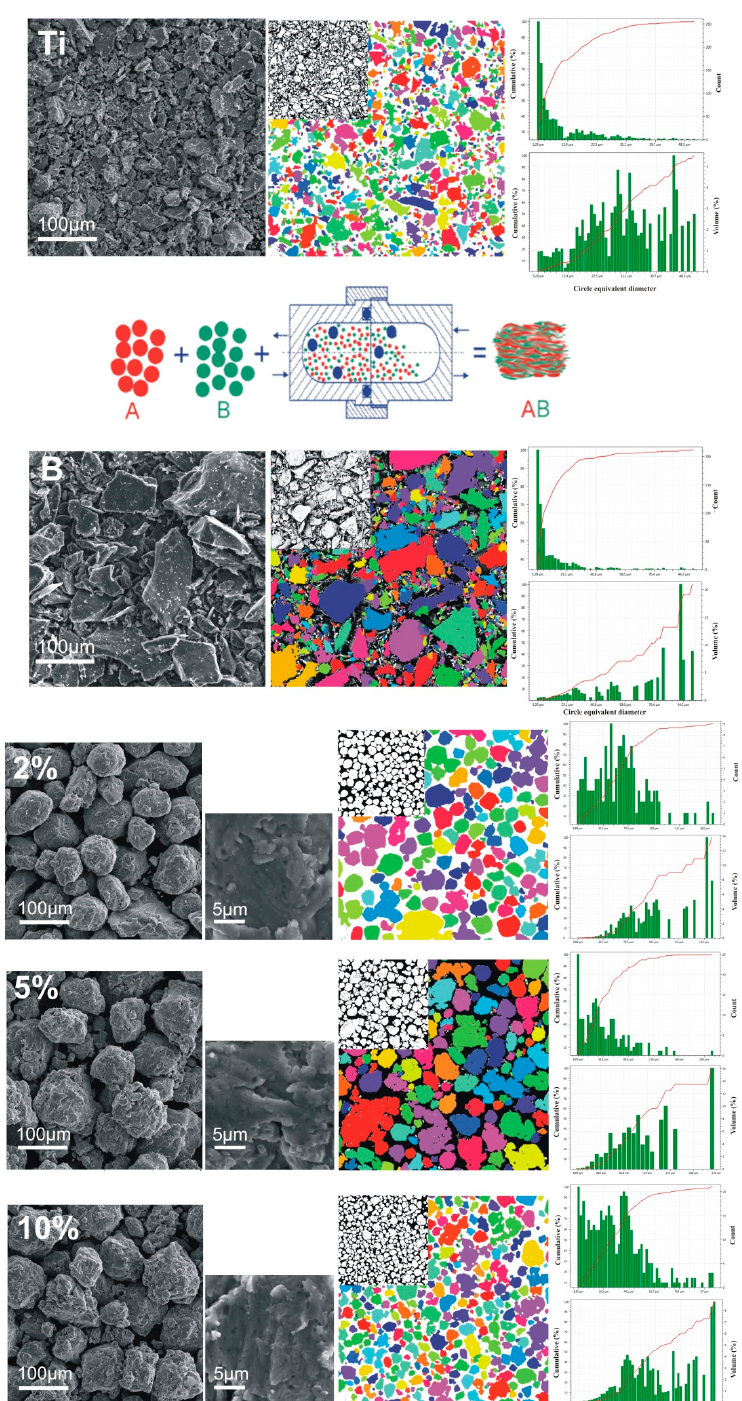
Figure 3. SEM microphotographs showing the powder blends processing stadium from the starting elementary titanium–Ti and boron–B powders to the 48 h mechanically alloyed precursor mixtures with different amounts of boron in the starting composition and their particle size distribution profiles in volumetric and count